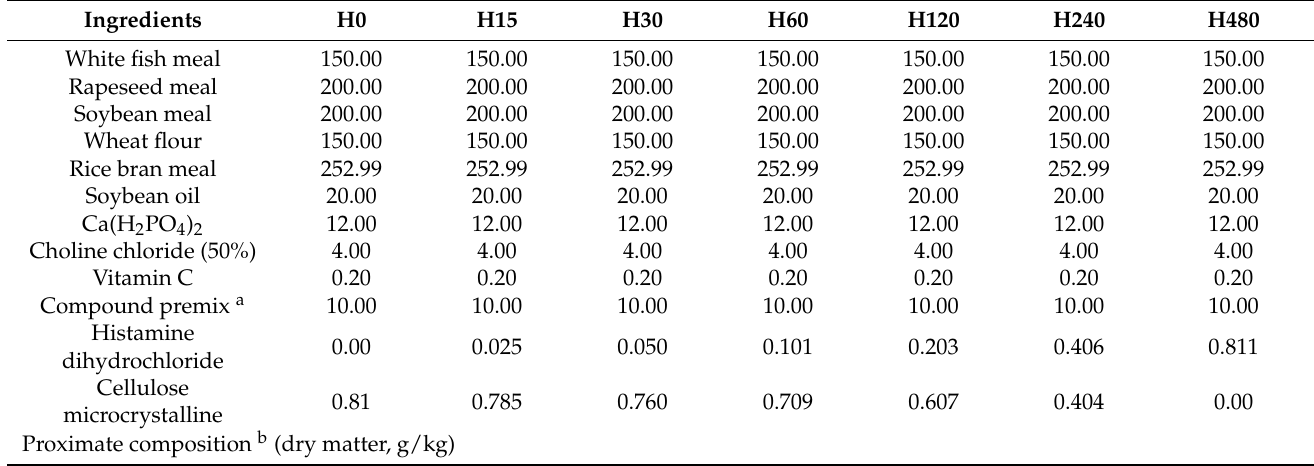
Table 2. Ingredients and nutritional compositions of the experimental